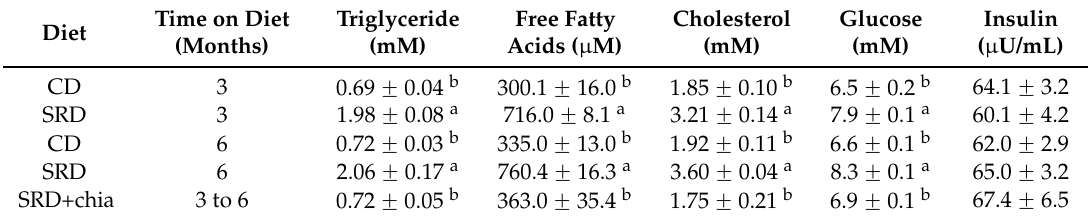
Table 5. Plasma metabolites of rats fed a control diet (CD), sucrose ‐ rich diet (SRD) or SRD + chia seed (SRD+chia) 1 .